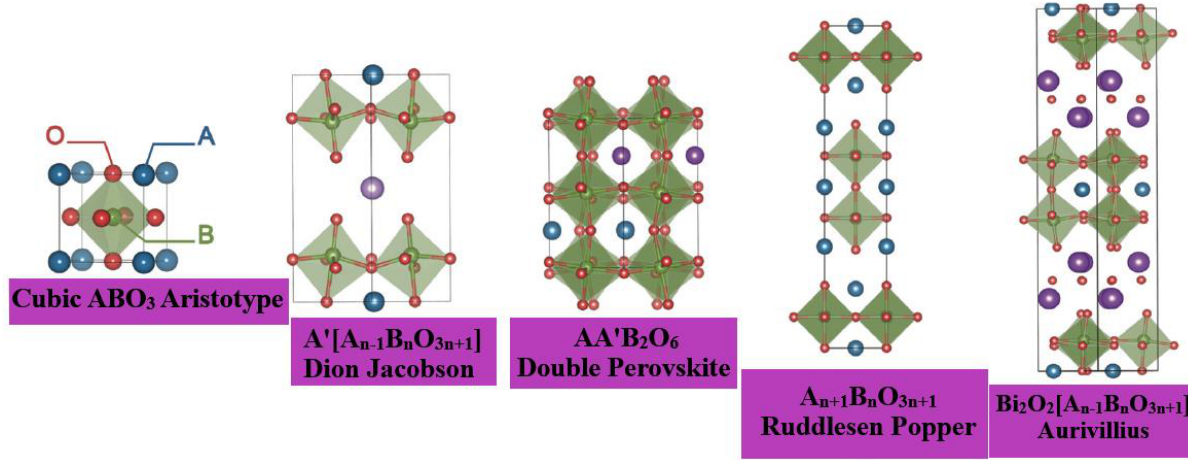
Figure 5. Layered perovskites — derived from the cubic ABO 3 aristotype — are discussed in this perspective. In the Dion Jacobson phases, A ′ is usually an alkali cation, but can also be a transition metal – halide complex, e.g., (MnCl) + . In the A-site ordered double perovskites, A ′ is chemically different from A. The perovskite blocks are interleaved between [Bi 2 O 2 ] 2+ layers in the Aurivillius phases. Adapted from Refs. [26,27] with permission from the European Society for Photobiology, the European Photochemistry Association, and The Royal Society of Chemistry.